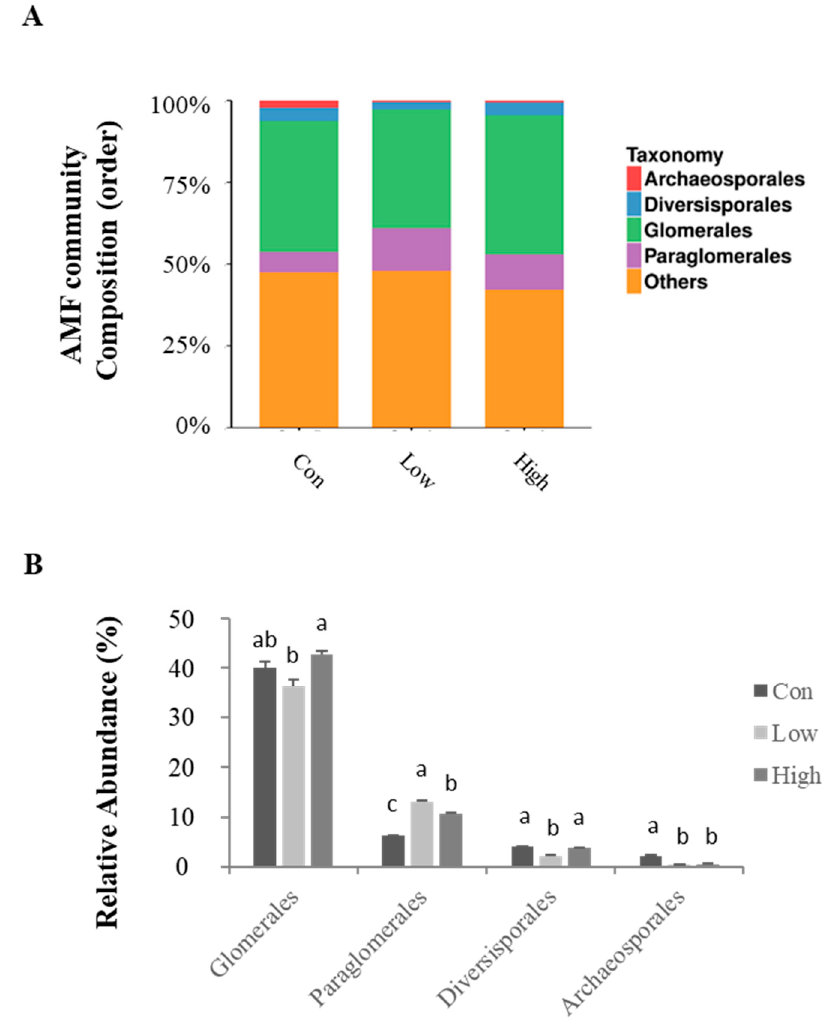
Figure 2. Relative abundance of the AMF community composition in rhizospheric soil at the order level. ( A ) The distributions of AMF community compositions at the order level. ( B ) Relative abundance of the AMF community composition at the order level. Con—no treatment; Low—biogas slurry (250 m 3 ha − 1 yr − 1 ) treatment; High—biogas slurry (375 m 3 ha − 1 yr − 1 ) treatment. Error bars represent the standard errors of three replications. Significant ( p < 0.05) differences between the treatments are shown by different lowercase letters.